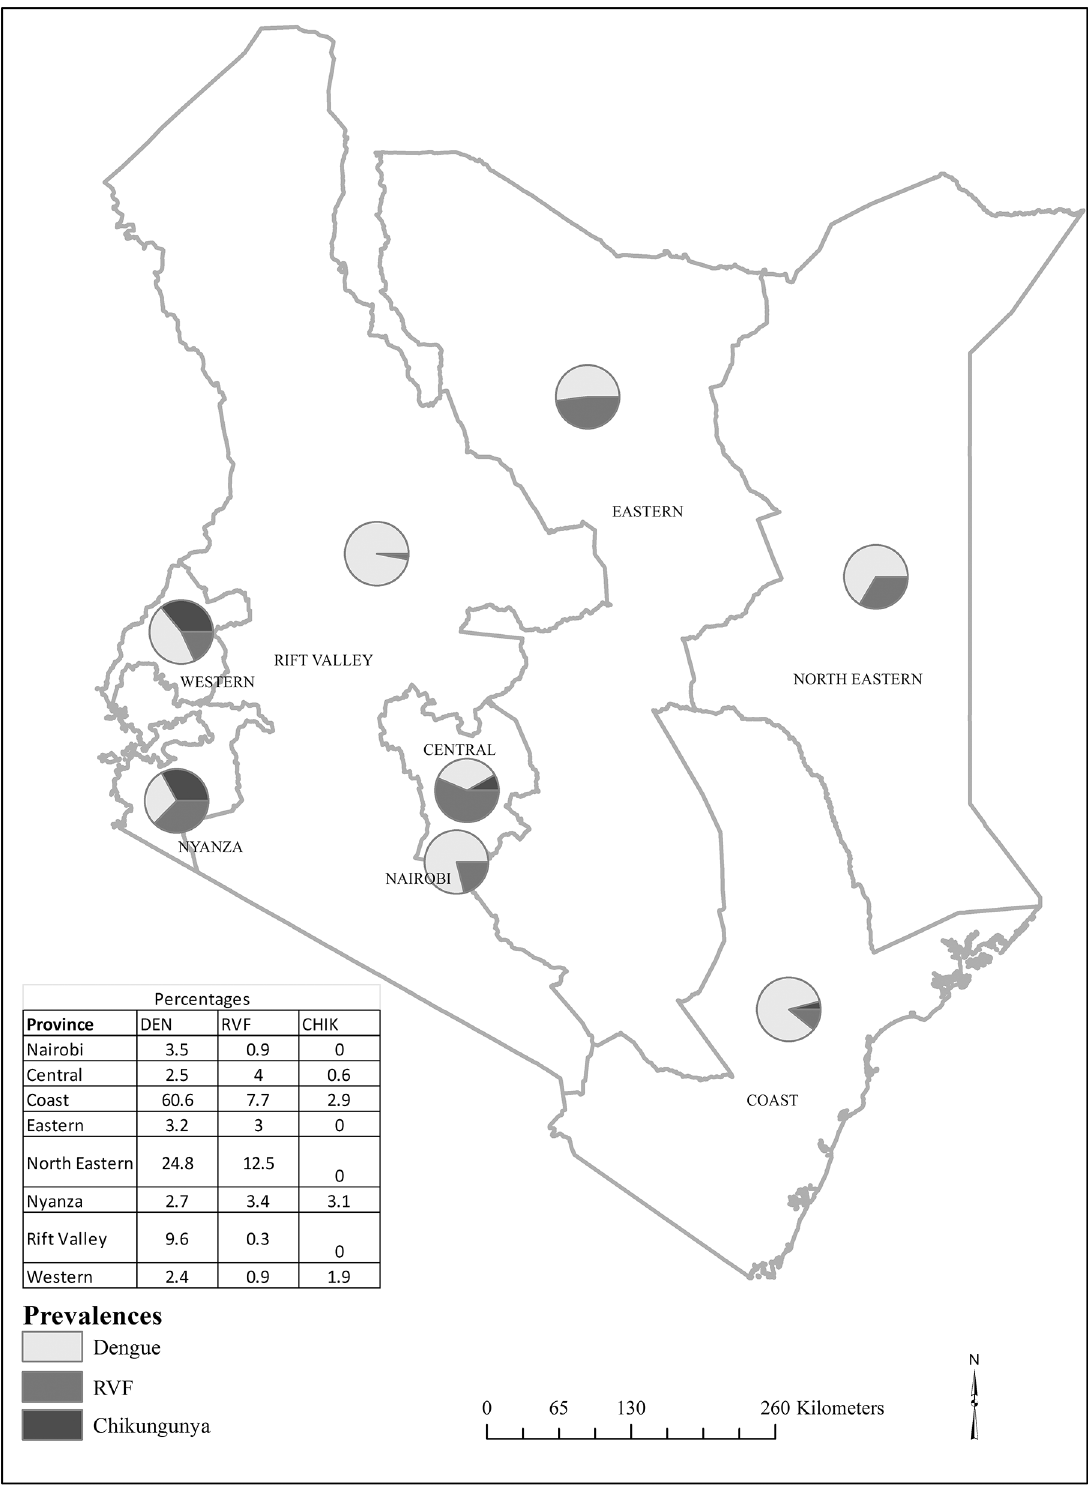
Fig 1. Seroprevalence of dengue, Rift Valley fever and chikungunya virus infections in Kenya.